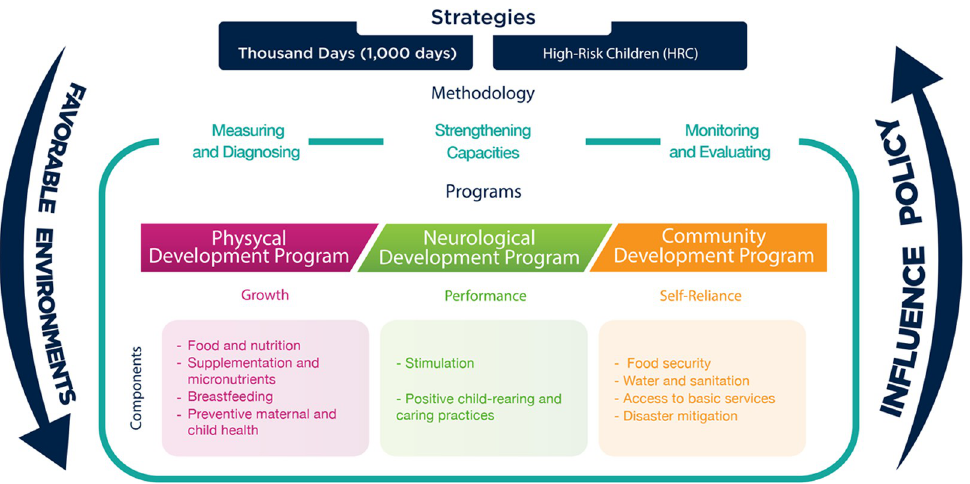
Fig 1. Comprehensive model for early childhood development ( MIDIT